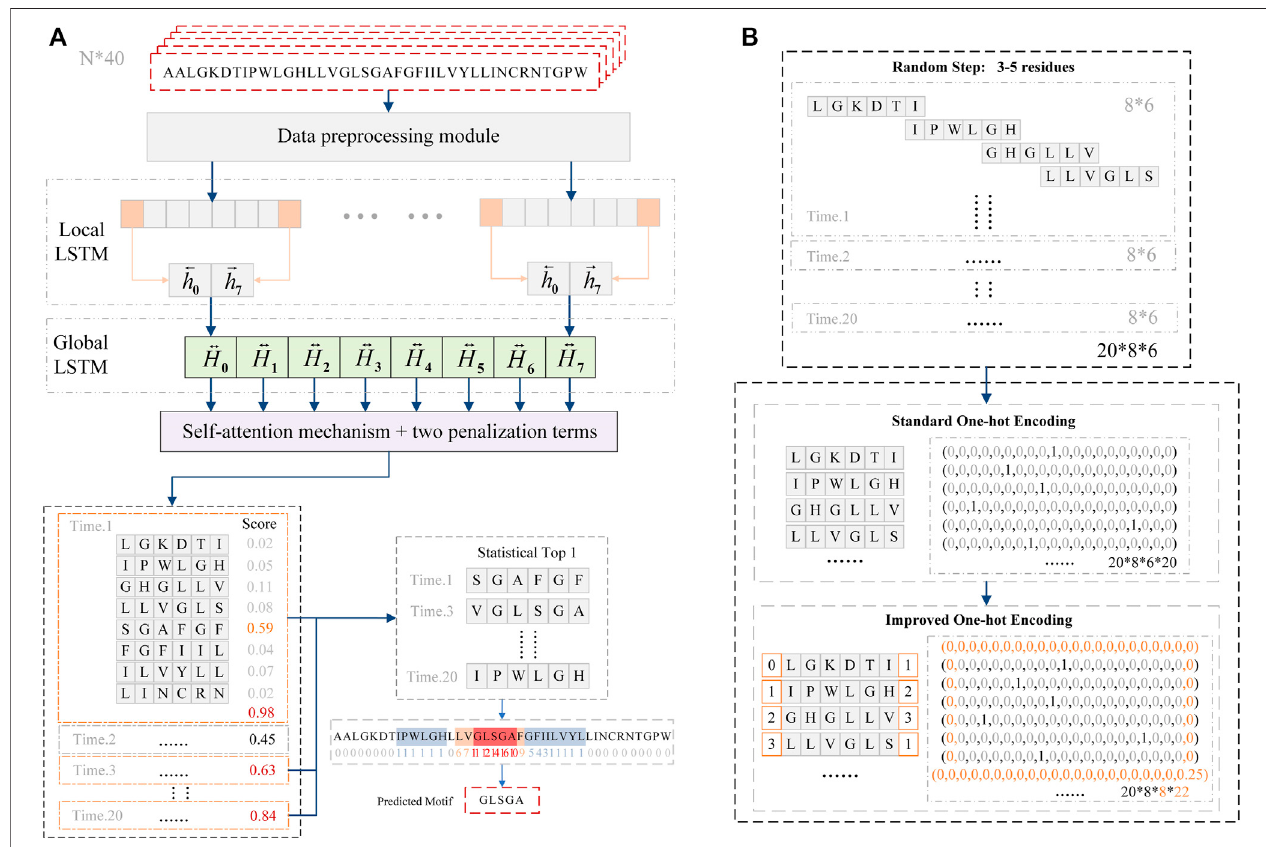
FIGURE1|(A) GLTMmodelcomposedofdatapreprocessingmodule,localBi-LSTMlayer,globalBi-LSTMlayer,andself-attentionlayer.Aftercontinuoustwenty times prediction, the model chose the subsequence fragment that was predicted more than 10 times as potential motif. (B) Data preprocessing module used no- fi xed step and improved one-hot encoding to encode original sequence